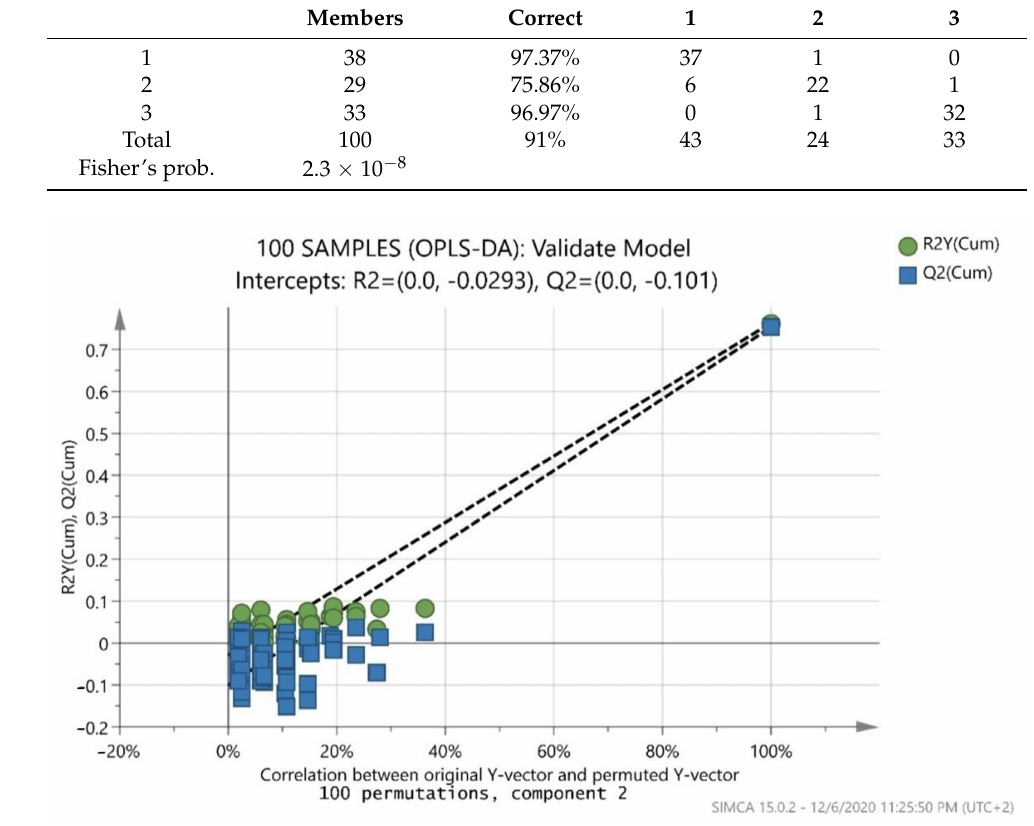
Figure 5. Permutation test of the overall model (whole database) with 100 permutations where both R 2 (original model) and Q 2 (predictive model) located at right and permutated R 2 (original model) and Q 2 (predictive model) located